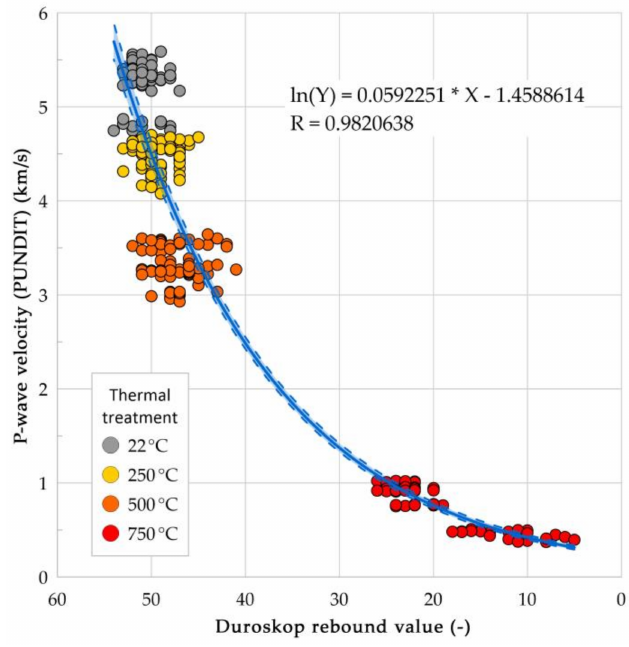
Figure 14. Scatter plot of Duroskop value vs. P-wave velocity. P-wave velocity and Duroskop show exponential correlation with an R-value of 98%. As P-wave velocity shows the best way to indicate the physical changes inside the samples and Duroskop value changes of the surface hardness change, the high correlation of these two parameters suggests that physical changes occur inside and outside the